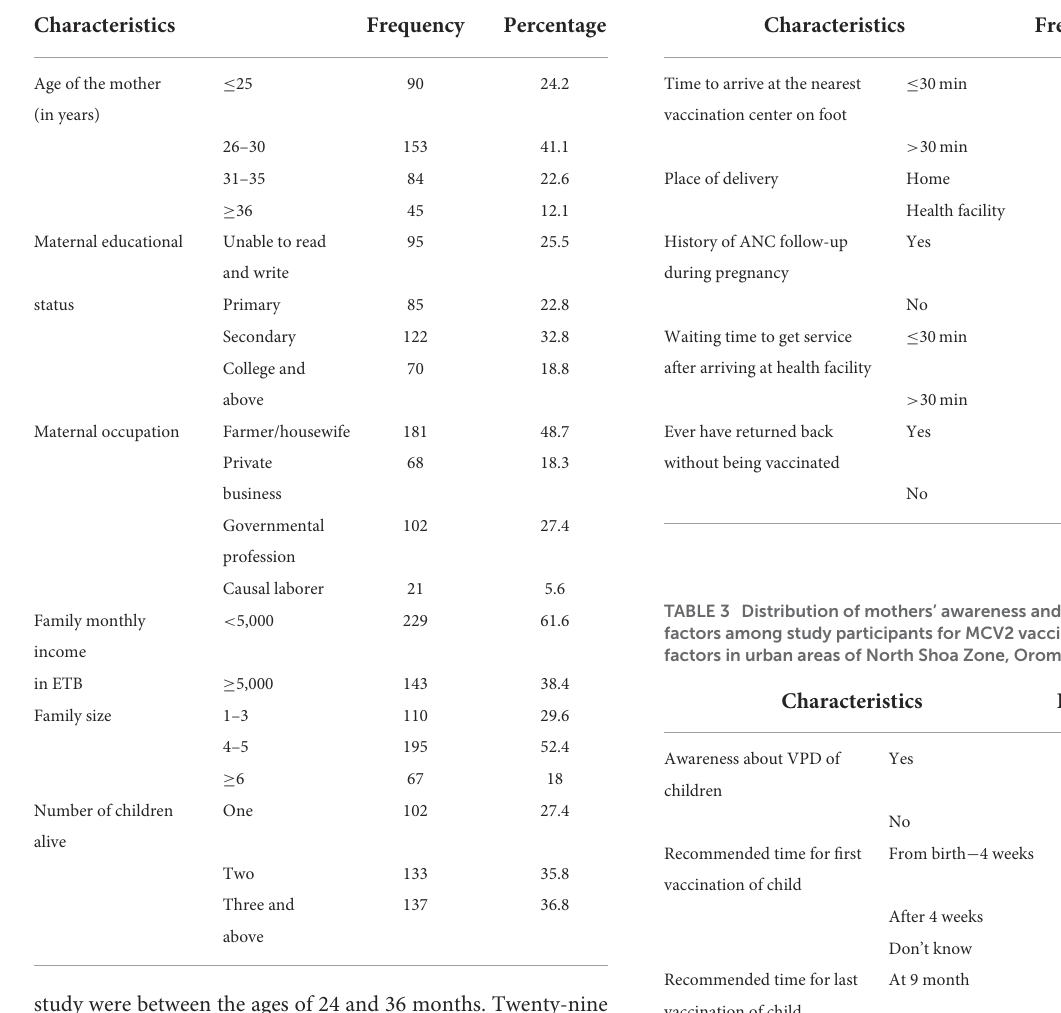
TABLE 1 Socio-demographic characteristics of mothers involved in the study of MCV2 vaccination and associated factors in urban areas of North Shoa Zone, Oromia Region, 2022.